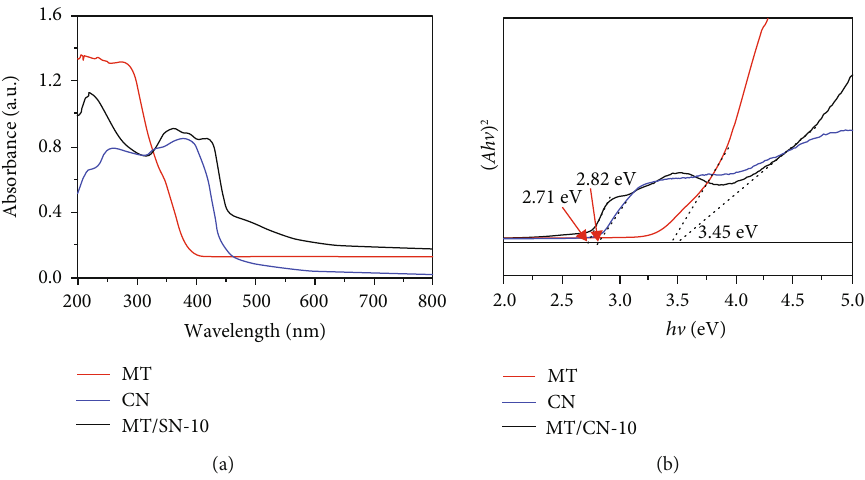
Figure 3: (a) UV-Vis absorption spectra and (b) the bandgap evaluation from the ( α h υ ) [2] photon energy plots for CN, MT/CN-10, and MT samples.